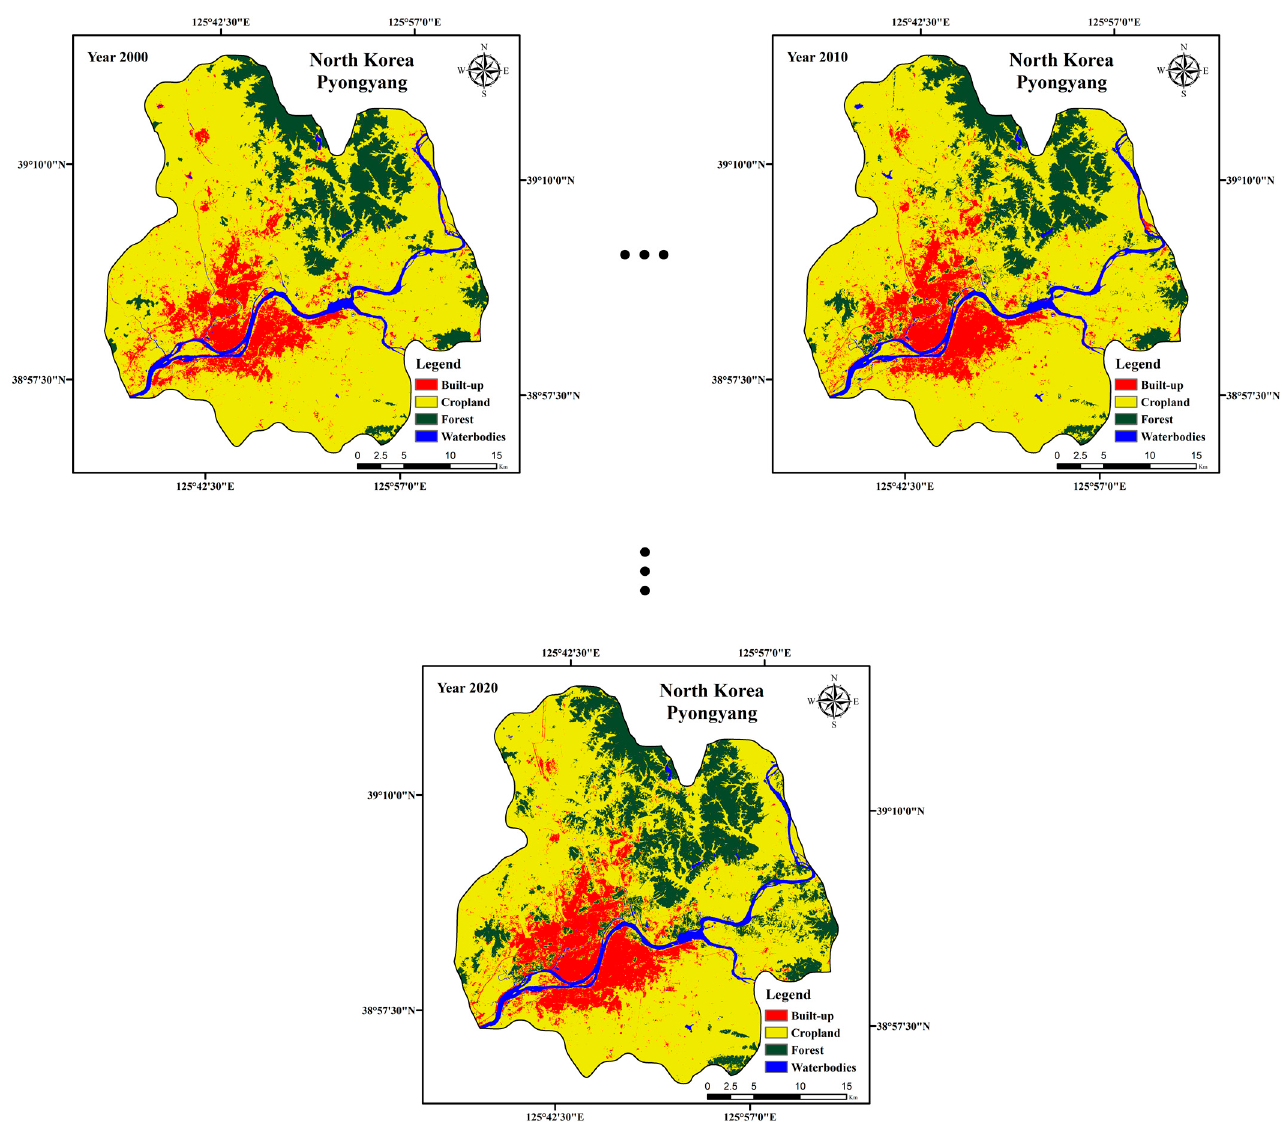
Figure 3. The time series LULC classification results from 2000 to 2020; Details based on 10 years as a period for 2000, 2010, and 2020.